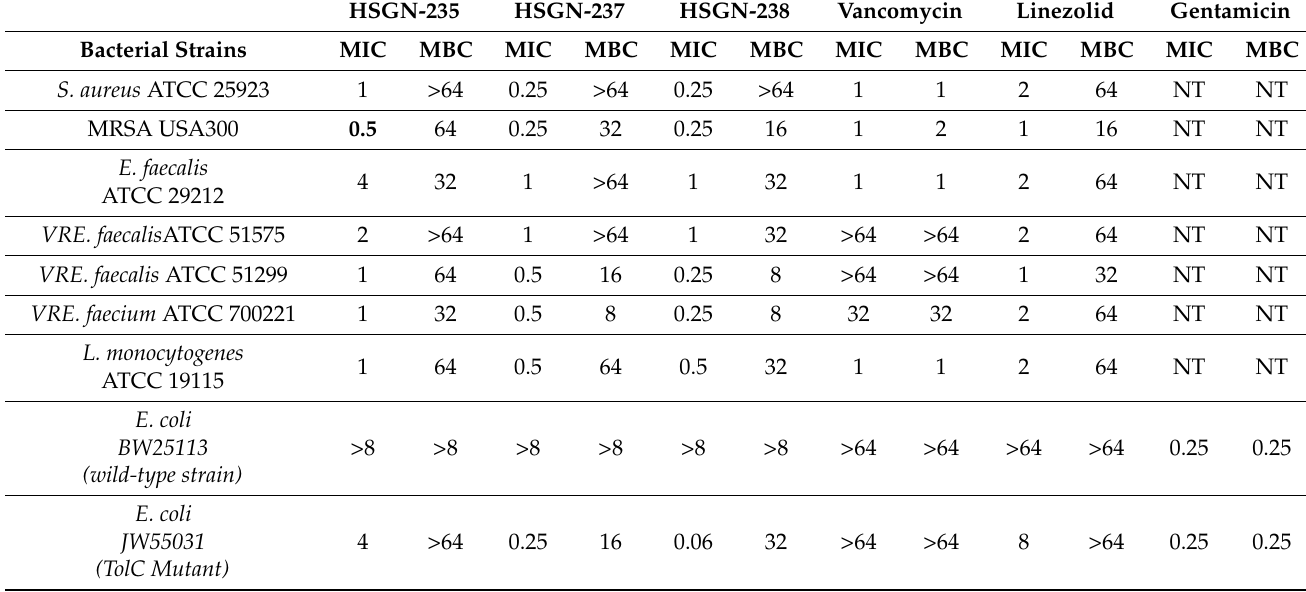
Table 3. MICs ( µ g/mL) and minimum bactericidal concentrations (MBCs, in µ g/mL) of HSGN-235, HSGN-237, and HSGN-238 and control drugs (vancomycin, linezolid, and gentamicin) against a panel of clinically important Gram-positive and Gram-negative bacterial pathogens including: Staphylococcus aureus , methicillin-resistant Staphylococcus aureus (MRSA) , Enterococcus faecalis , Enterococcus faecium, Listeria monocytogenes , and Escherichia coli. The experiment was repeated three independent times and the same MIC values were